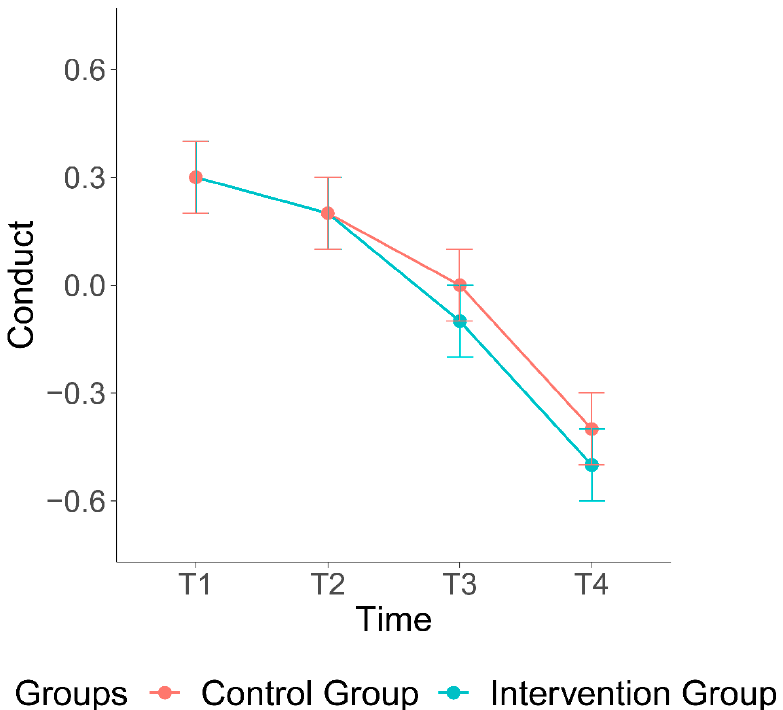
Figure 2. Effect of the VIPP-Intervention on conduct problems.